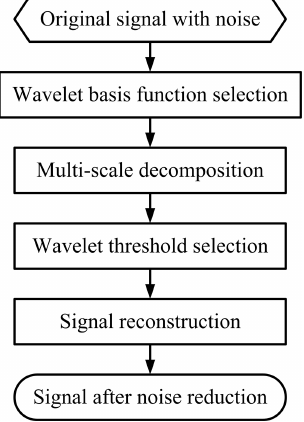
Figure 2. Wavelet threshold noise reduction flow chart.